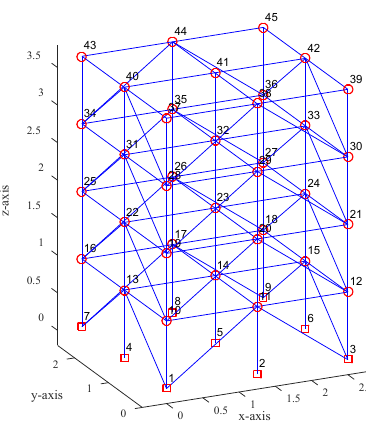
Figure 10. The ASCE benchmark finite element model.